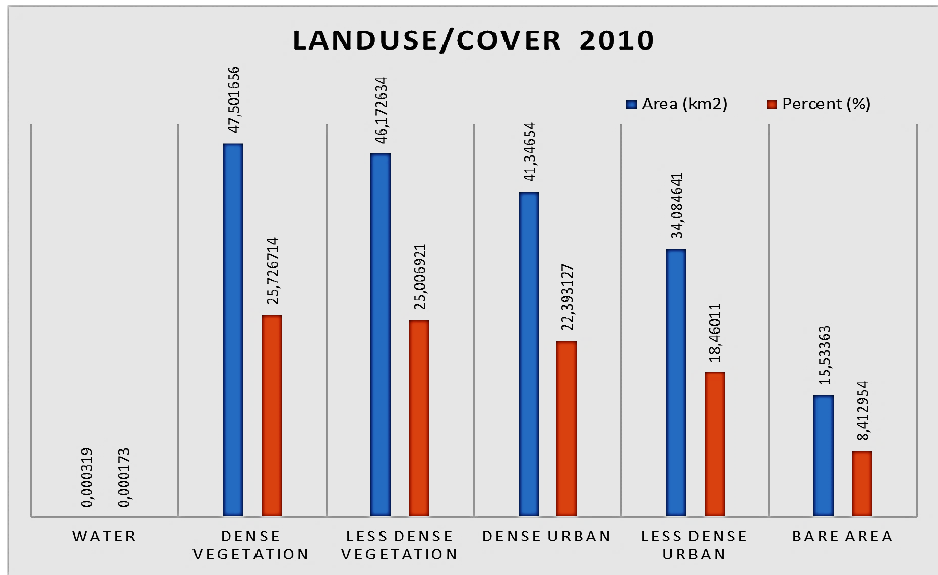
Figure 8. Land used/cover for 2010.